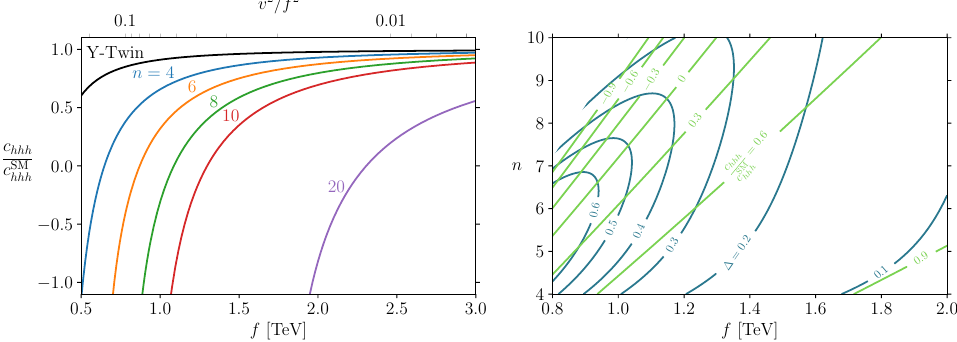
Figure 3 . (Left) Ratio of the Higgs trilinear self-coupling to its SM expectation. (Right) Contours indicating the total fine-tuning ∆ and the c hhh /c SM coupling deviation in the plane of input pa- hhh rameters { f, n } . We do not consider the region in the upper-left corner where the first minimum is not the global